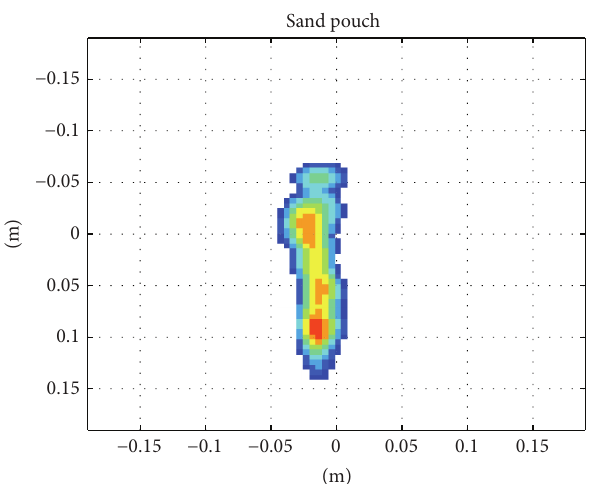
Figure 12: Toy gun, with very sparse